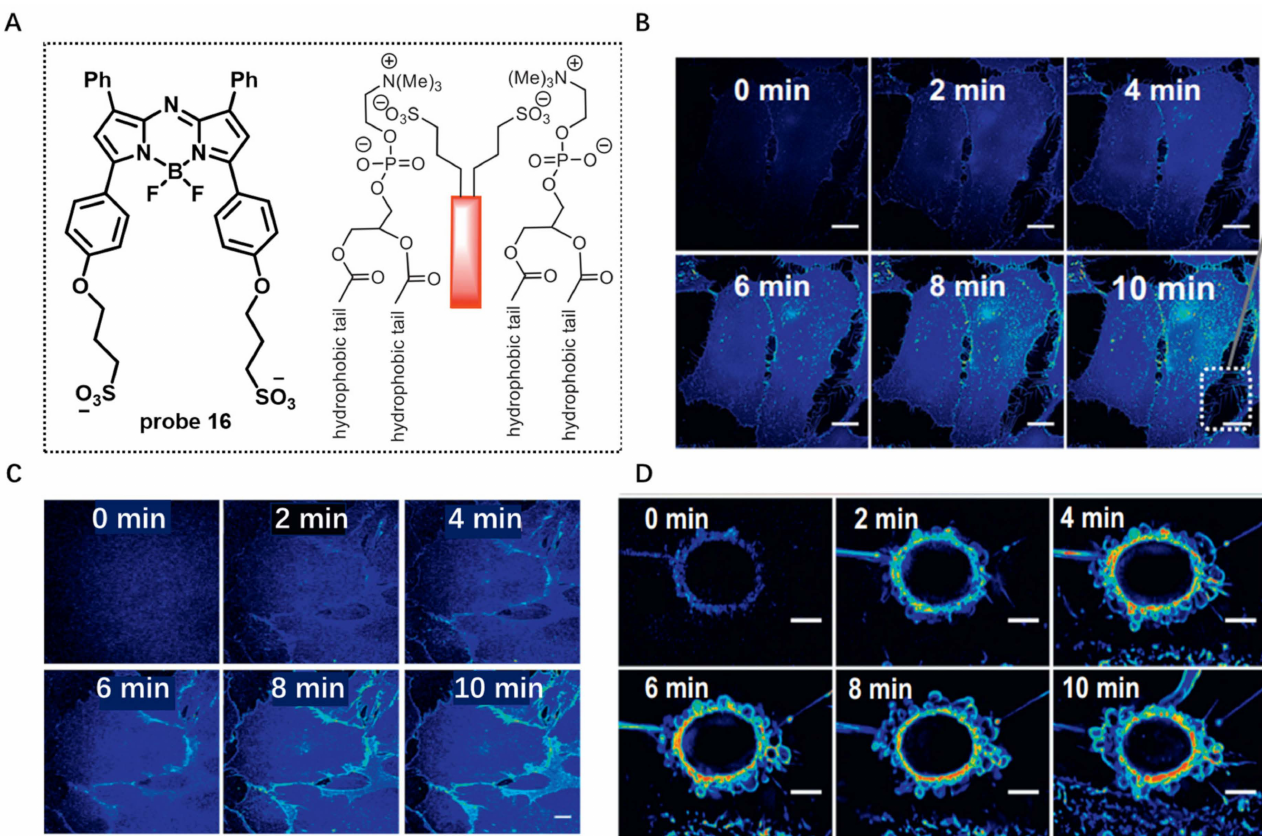
Figure 16. ( A ) Chemical structure of probe 16 and its interaction with membrane bilayer. ( B , C ) Live cell imaging in HeLa Kyoto and MC3T3 using probe 16 . Scale bar: 20 µ m. ( D ) Real-time image of apoptotic cell with probe 16 . Scale bar: 20 µ m. Copyright 2018 Elsevier